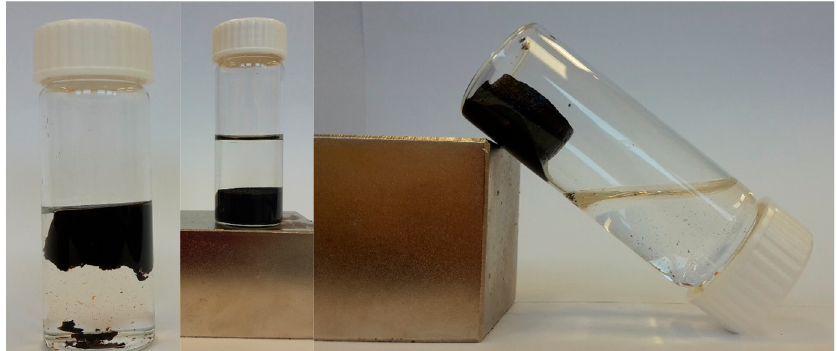
Figure 3. The photographs of magnetic PEO/iron oxide gel attracted by a permanent magnet. Nanomaterials 2019 , 9 , x FOR PEER REVIEW